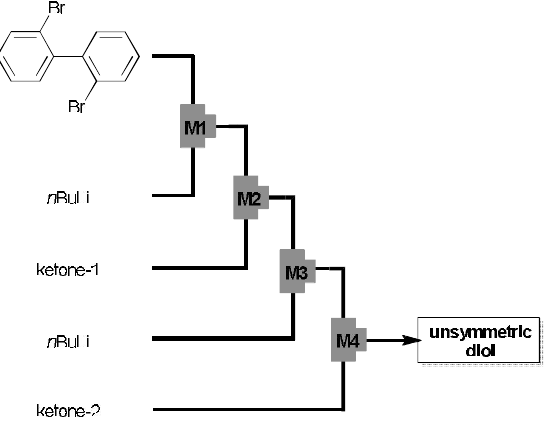
Figure 1. An integrated flow microreactor system for the sequential introduction of two different diarylmethanol units at the 2,2'-position of